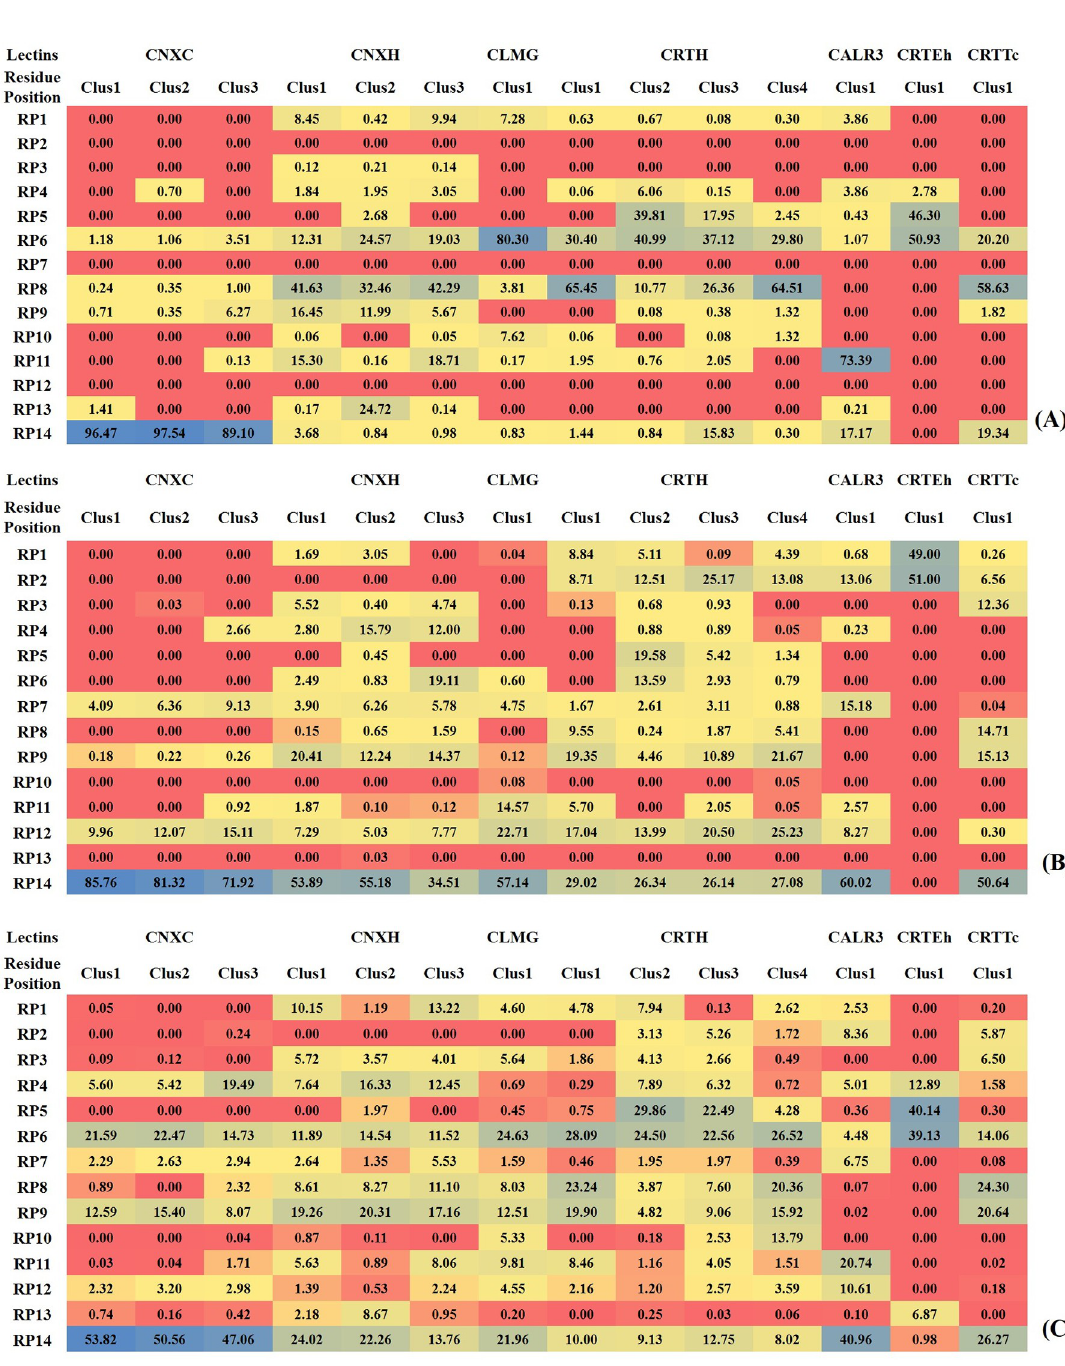
Fig 4. Heatmaps showing the residue position-wise noncovalent bond interactions in clusters of lectins: (A) hydrogen bonding of various conformers with monoglucosylated N-glycans; (B) hydrophobic interactions; and (C) van der Waals contacts.